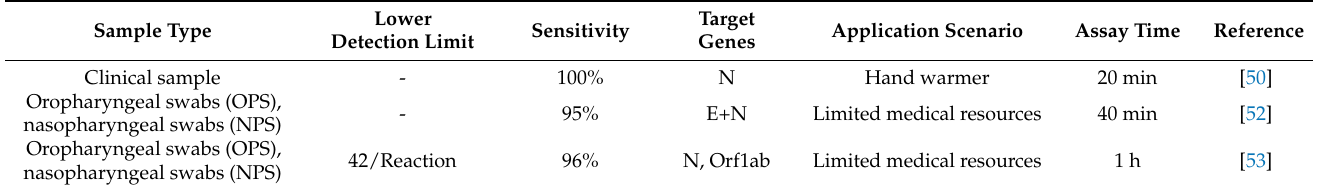
Table 3. The data and applications of off-chip CRISPR–Cas detection technology are